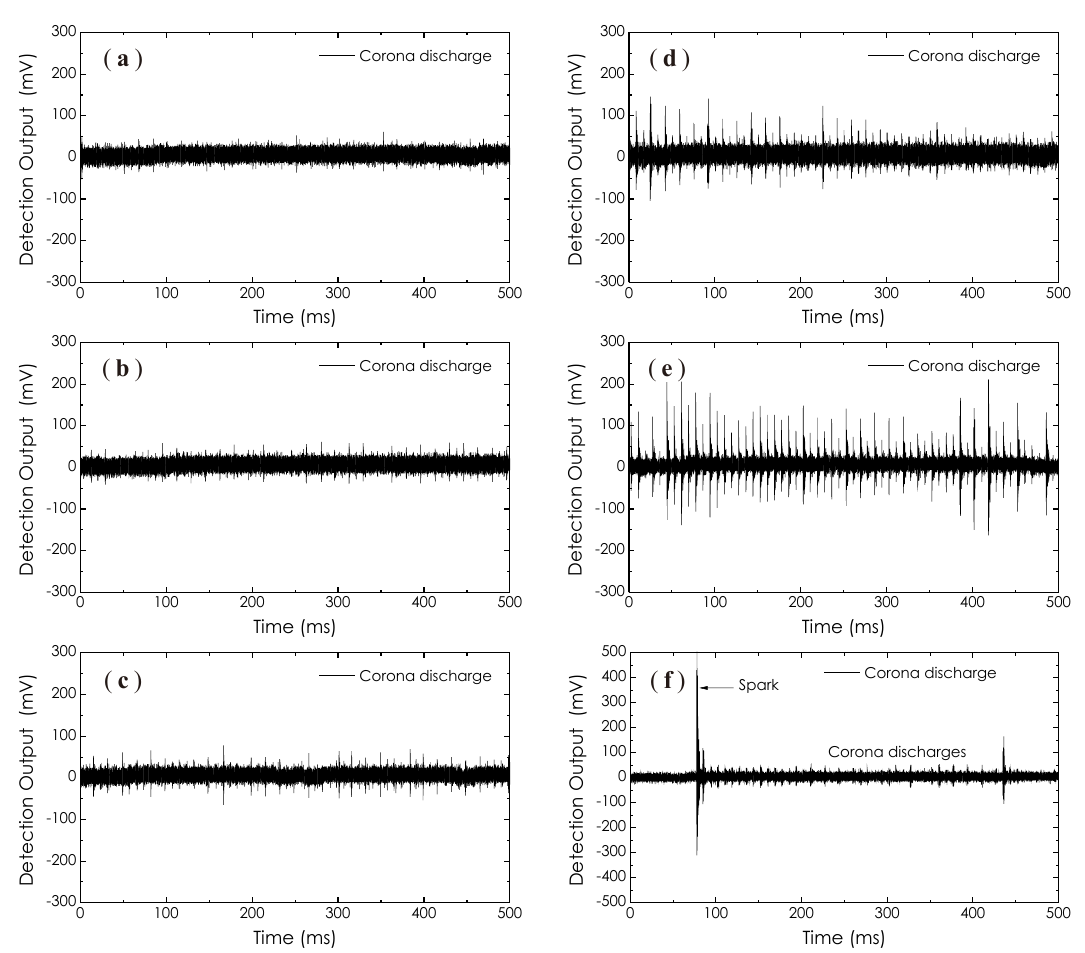
Figure 17. Experimental results on the sensing of corona discharges occurring within an empty metal tank. From ( a ) to ( e ), the imposed AC high voltage increased gradually, large spark pulses ( f